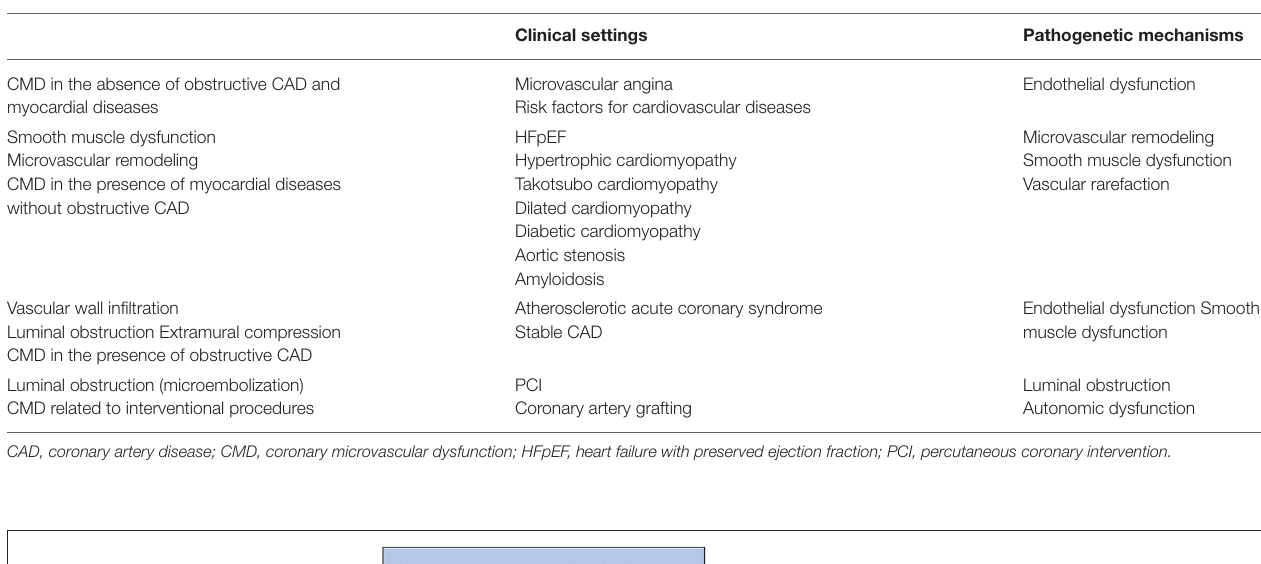
TABLE 1 | Classification of coronary microvascular dysfunction.